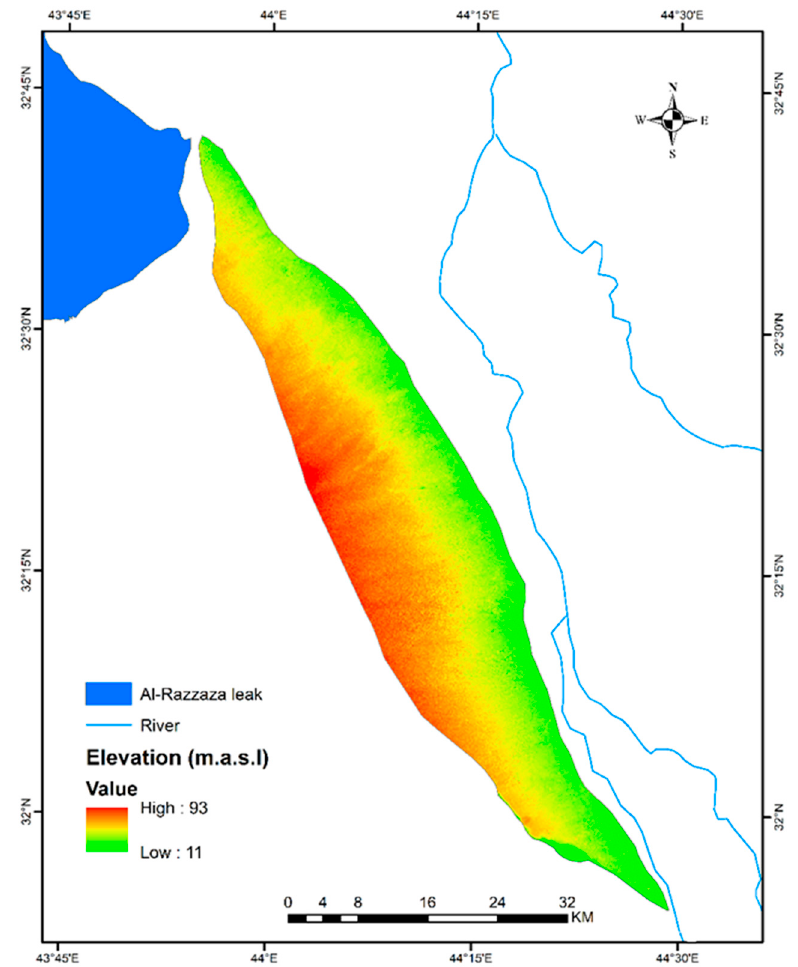
Figure 5. DEM of the study